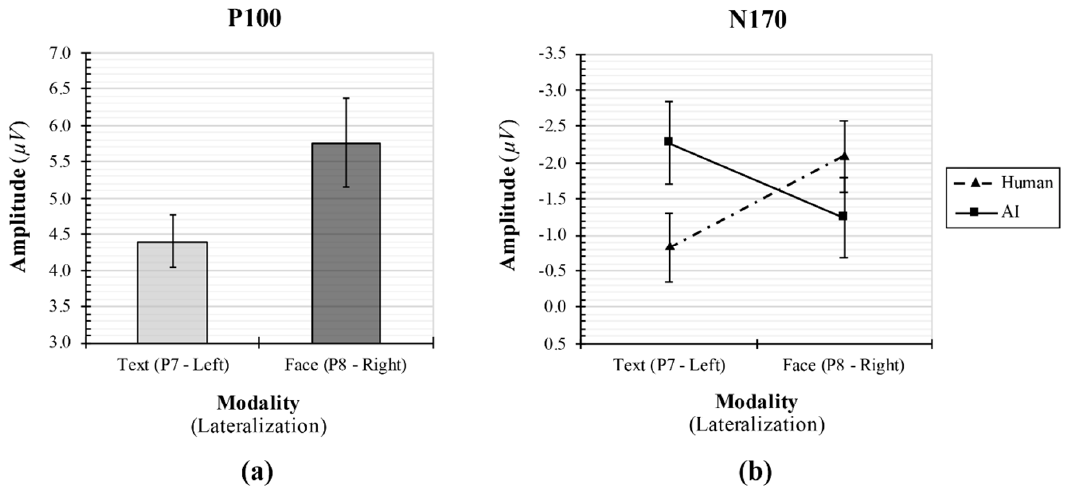
Figure 4. ( a ) Main effect of agent’s identity modality on changes in P1 (P100) amplitude and ( b ) interaction effect of agent’s identity type and modality on changes in N170 amplitude.